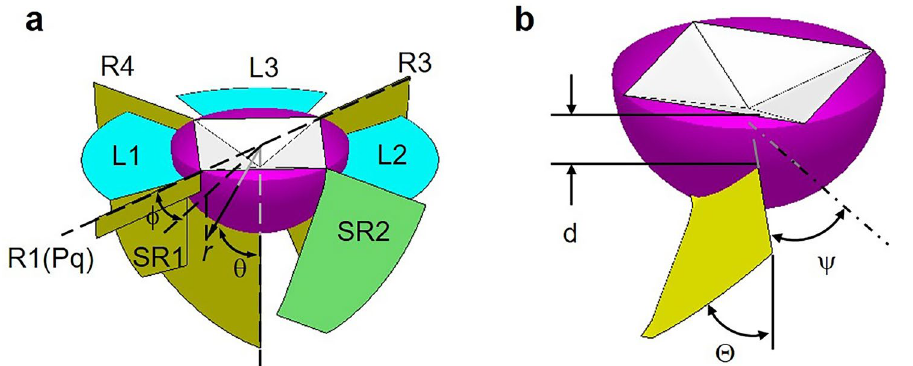
Figure 4. Schematic illustration of crack system induced by Vickers indentation around the indent and the semispherical process zone. ( a ) A crack model for loading at 29.4 N. Radial crack (R), secondary radial crack (SR), Palmqvist crack (Pq), lateral crack (L). Coordination system used to define the stress field at an indentation contact is illustrated. ( b ) Geometry of an inclined